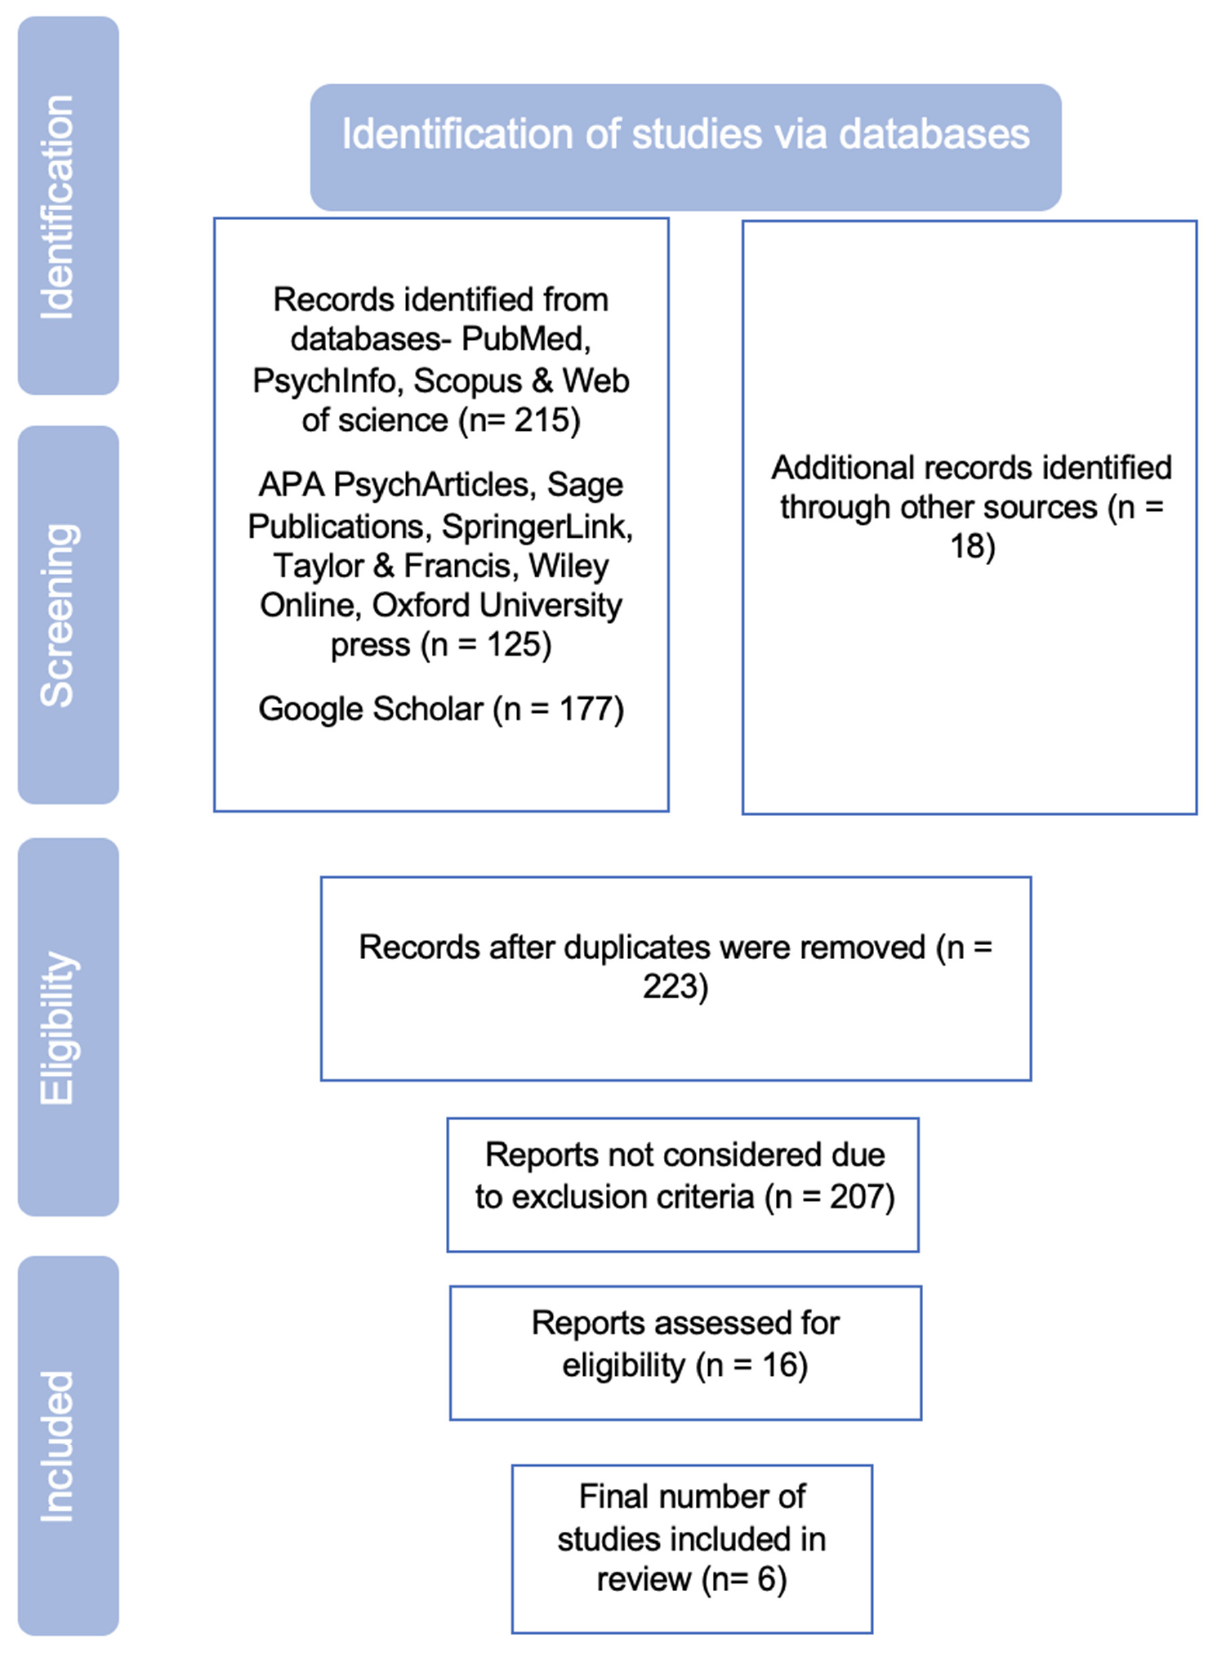
Figure 1. PRISMA flowchart of the search